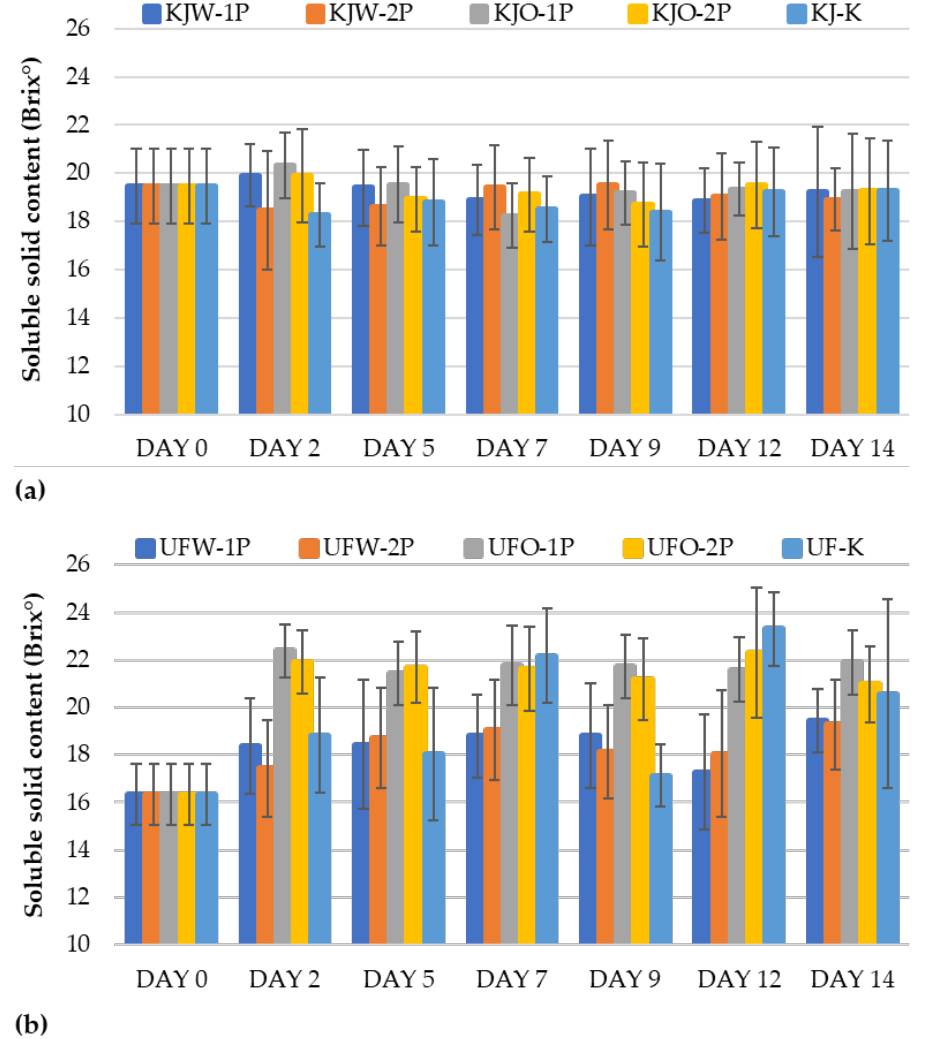
Figure 6. Change in soluble solid content (Brix ˘ ) during the storage of control and MAP: ( a ) ‘Kántorjánosi’ and ( b ) ‘Újfehértói fürtös’ sour cherries with different washing pretreatments.